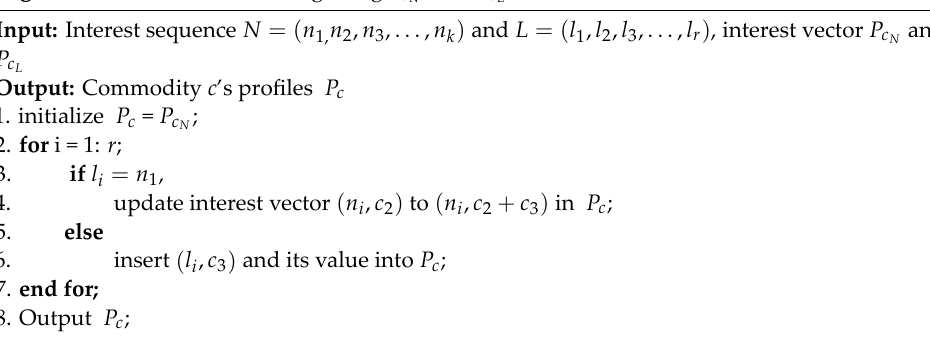
Algorithm 2. Procedure for integrating P c